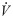
Effect of hypoxia on LV twist and untwisting rate during exercise.Despite the same whole-body oxygen consumption (V˙O2) and LV volumes, hypoxia significantly increased LV twist mechanics (A), indicating that relative exercise intensity cannot be the sole determinant of the absolute magnitude of LV twist mechanics. However, when LV twist mechanics were plotted against rate pressure product (RPP), a clear linear relationship was observed, suggesting that myocardial work may ultimately predict the magnitude of LV twist and untwisting rate (B).